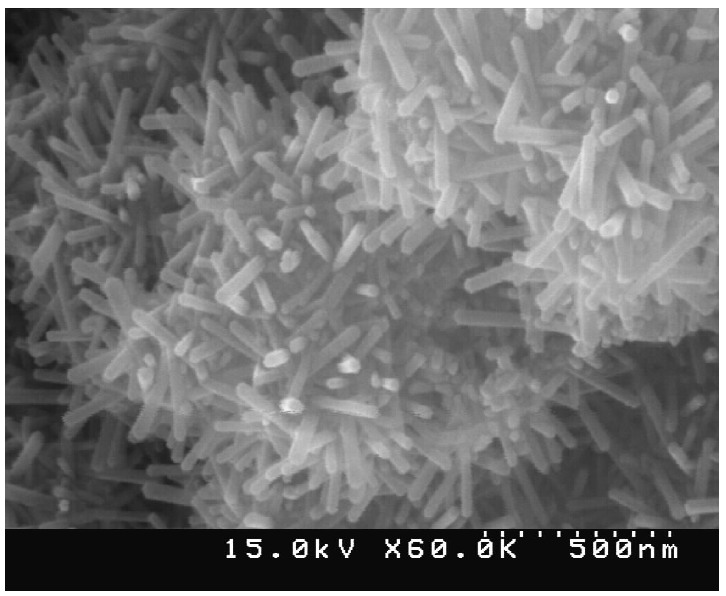
Figure 11. SEM image of Bi 2 O 3 nanorods produced by thermolysis of nanostructure 1 at 170 °C.